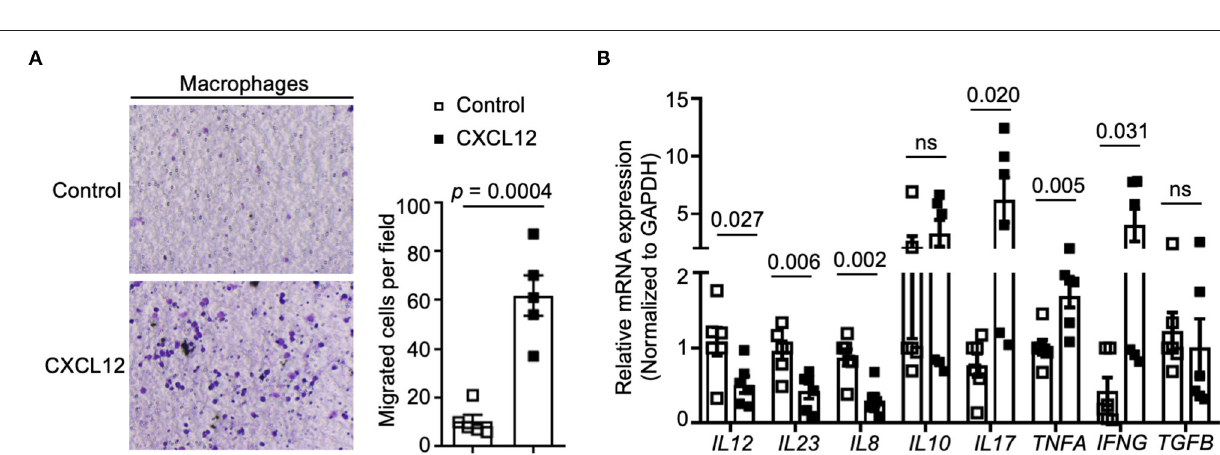
FIGURE 6 | CXCL12 regulated macrophages’ recruitment and cytokines expression. (A) Transwell assays were performed to measure cell recruitment capacity, and the numbers of migrated cells were counted ( right panel ). Macrophages were stimulated with CXCL12 (100ng/ml) or not ( n = 5). (B) Relative expression of IL-12, IL-23, IL-8, IL-10, IL17A, TNF- α , IFN- γ , and TGF- β were analyzed by qRT-PCR. Individual data are shown as Mean ± SD. Statistical analysis was carried out using unpaired t